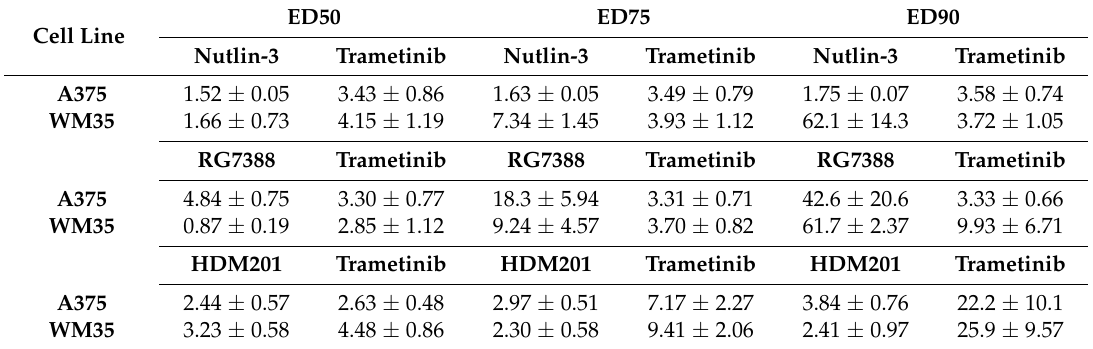
Table 1. Summary of dose reduction index (DRI) for the combination treatment in A375,